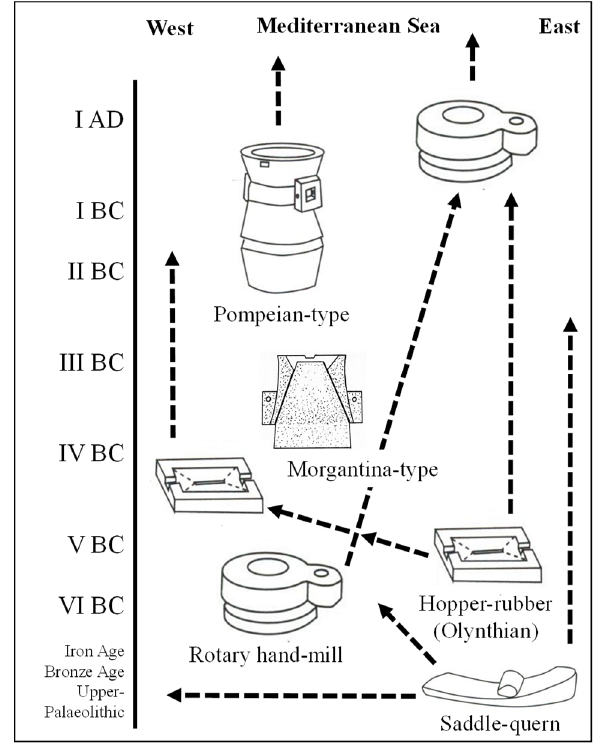
Figure 1. Sketch diagram showing the chronology of appearance of the di ff erent milling techniques in antiquity and their inferred di ff usion throughout the Mediterranean Sea (roughly from East to West and vice versa). See also text (introduction section) for a more detailed framework of their first appearance and trade.